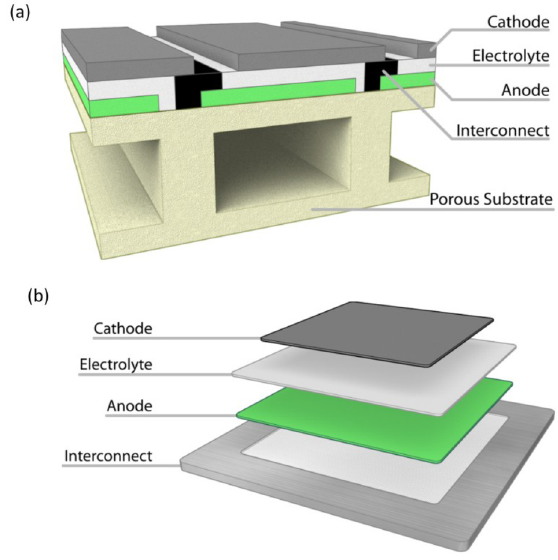
Figure 5. ( a ) Ceramic supported and ( b ) Metal supported cell designs [8].